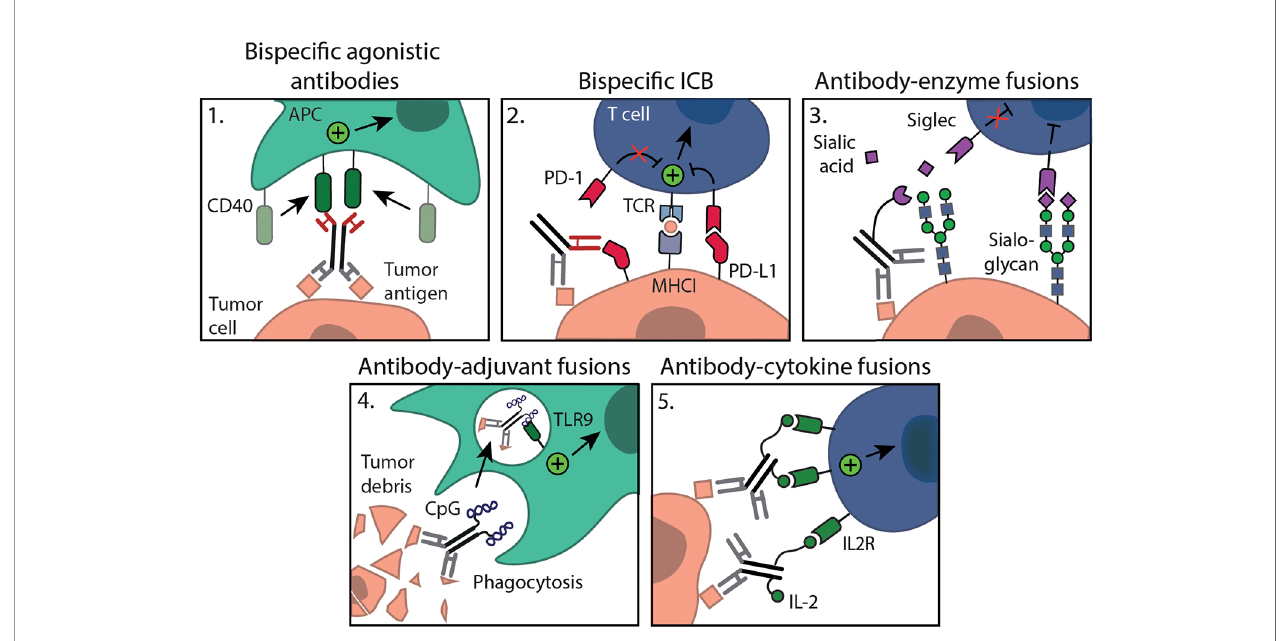
FIGURE 2 | Multifunctional antibody formats for combination with in situ tumor ablation. Administration of 1. bispeci fi c agonistic antibodies (e.g. anti-MSLN-CD40) or 4. antibody-adjuvant fusions (e.g. chTNT3-CpG) will lead to local APC activation. Interventions such as 2. bispeci fi c ICB (e.g. PD-L1xErbB2 antibody) may further stimulate myeloid as well as T cell immunity speci fi cally within the TME; 3. antibody-enzyme fusions allow tumor speci fi c sialoglycan degradation (e.g. anti-HER2 mAb-sialidase); 5. antibody-cytokine fusions (e.g. anti-GD2-IL2) will result in targeted cytokine delivery ensuring local immune cell activation, all are aimed at relieving local